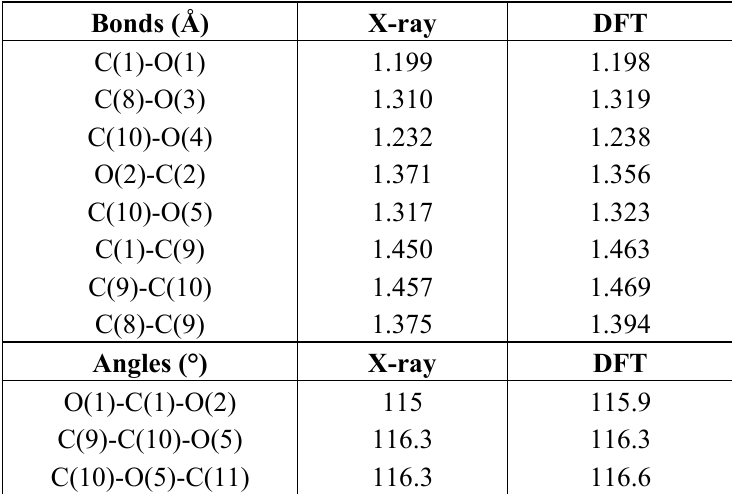
Table 5. Comparison of bond lengths and angles.